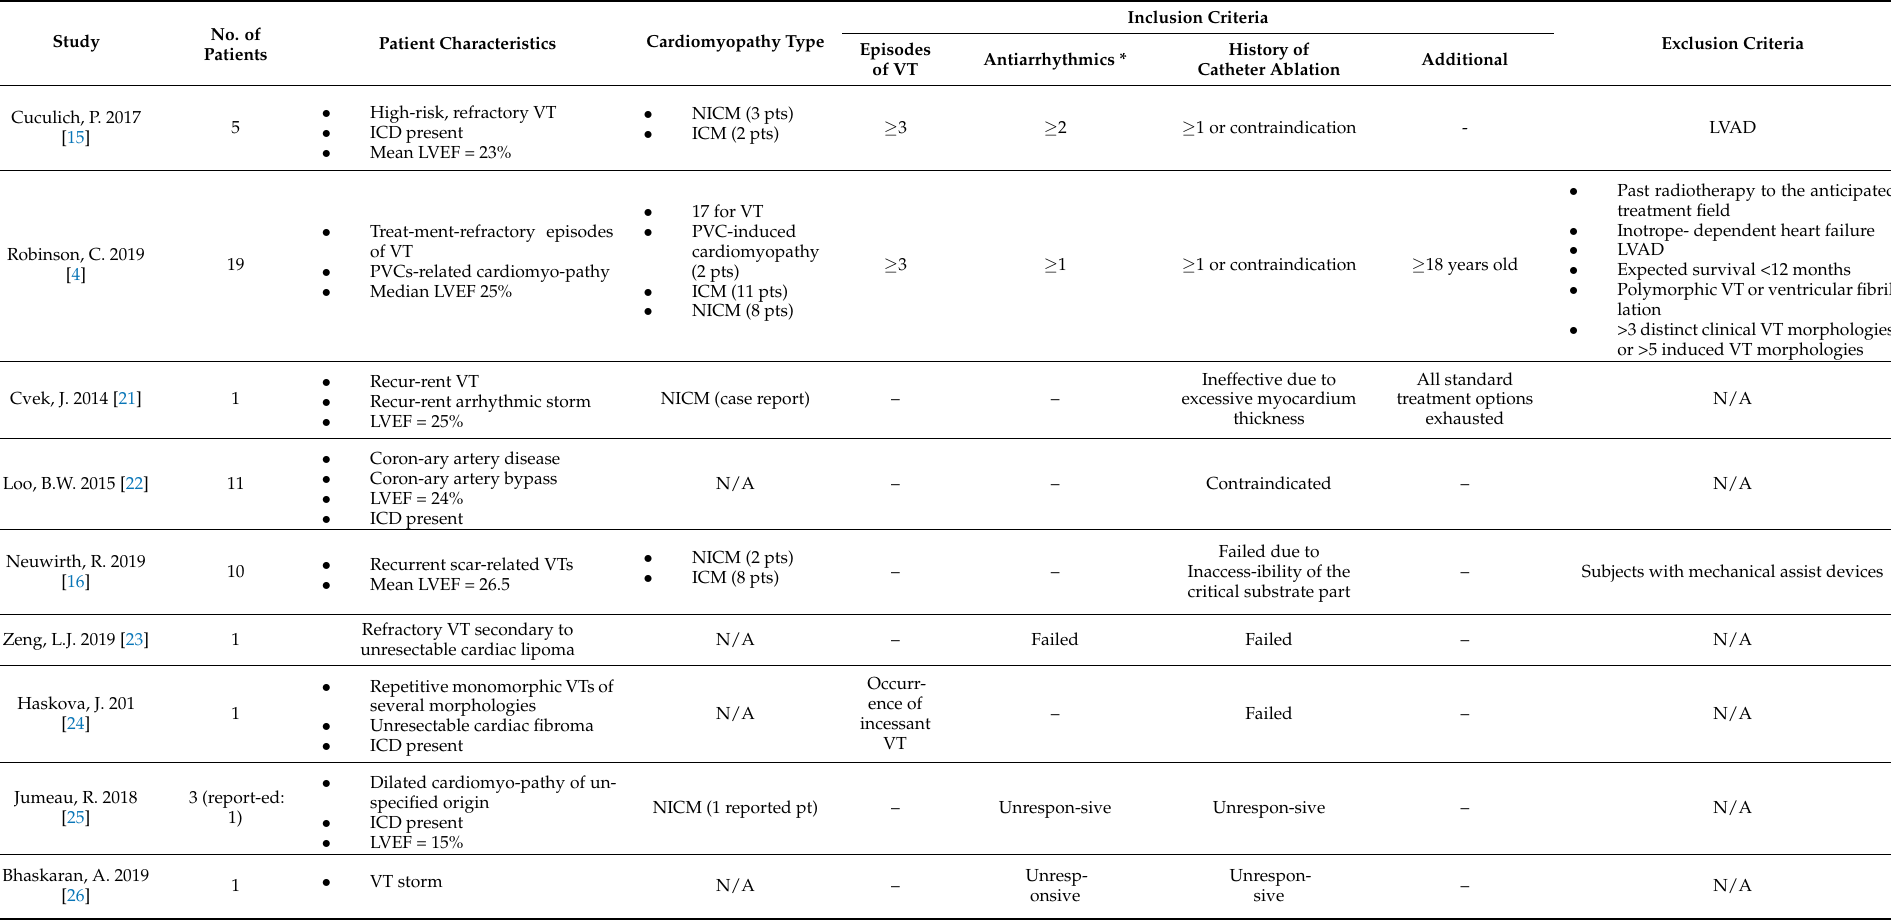
Table 1. Patient characteristics and inclusion criteria for STAR